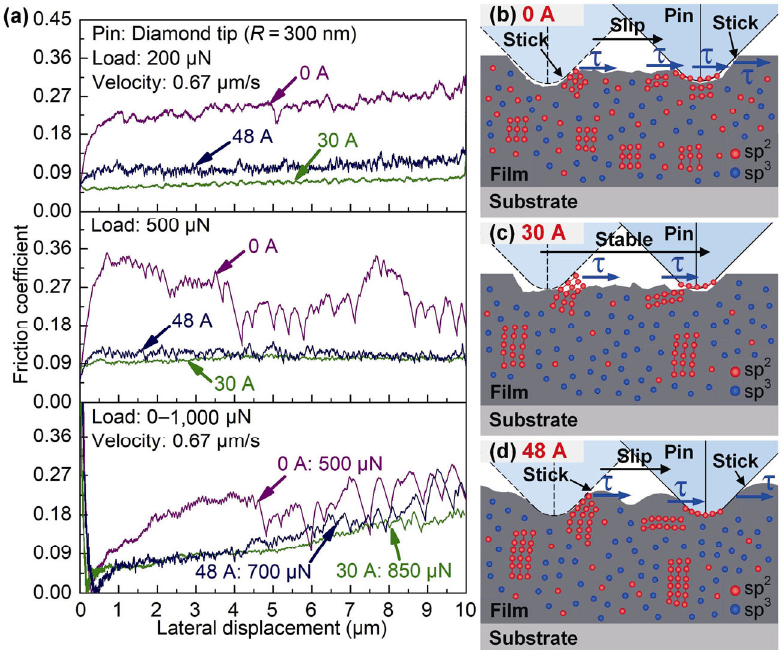
Fig. 8 (a) Nanofriction curves with I s of 0, 30, and 48 A at the constant loads of 200 and 500 µN, and ramp load of 0–1,000 µN. (b–d) Schematics of the frictional mechanisms for the three films shown in (a).